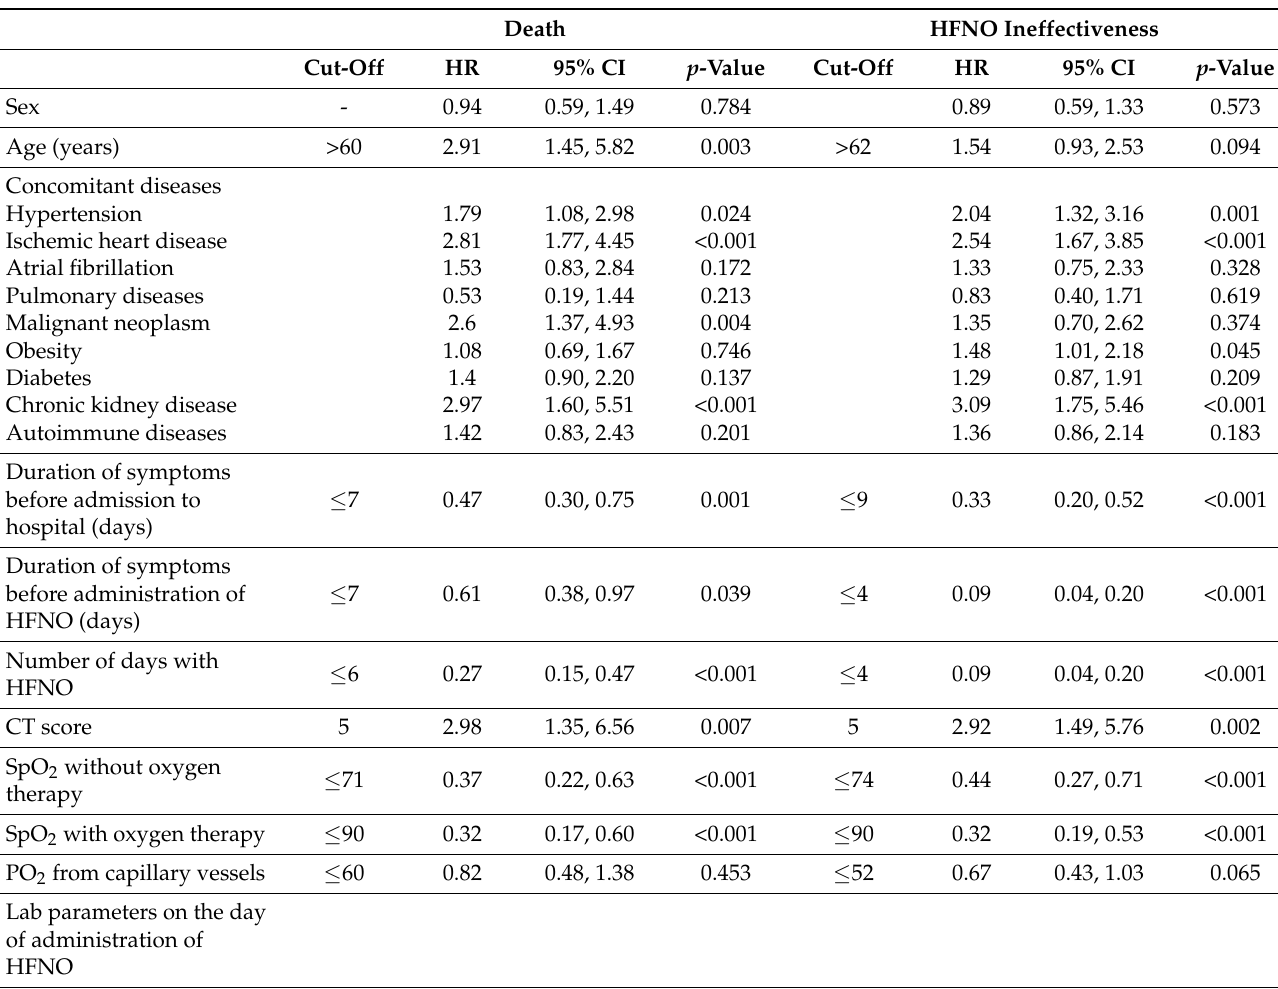
Table 2. Univariate cox regression model for survival and HFNO effectiveness as dependent